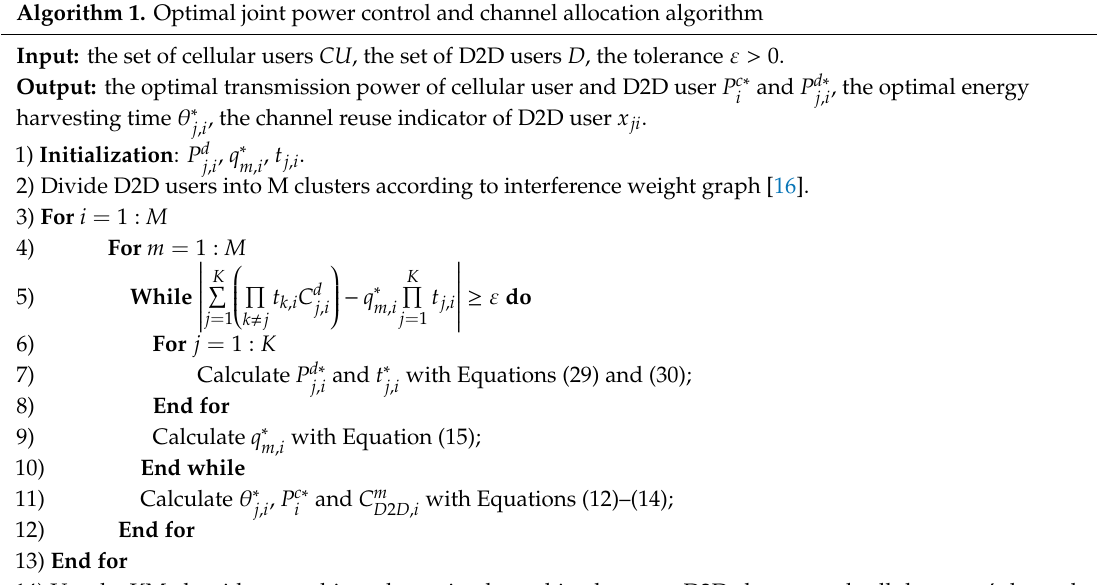
Algorithm 1. Optimal joint power c ontrol and channel allocation algorithm